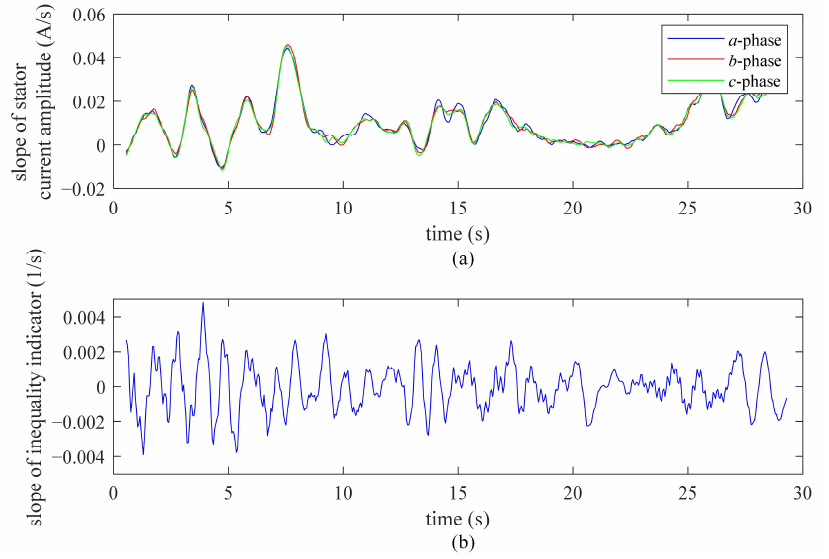
Figure 3. ( a ) The slopes of the stator current amplitudes, ( b ) the slopes of the inequality indicator.